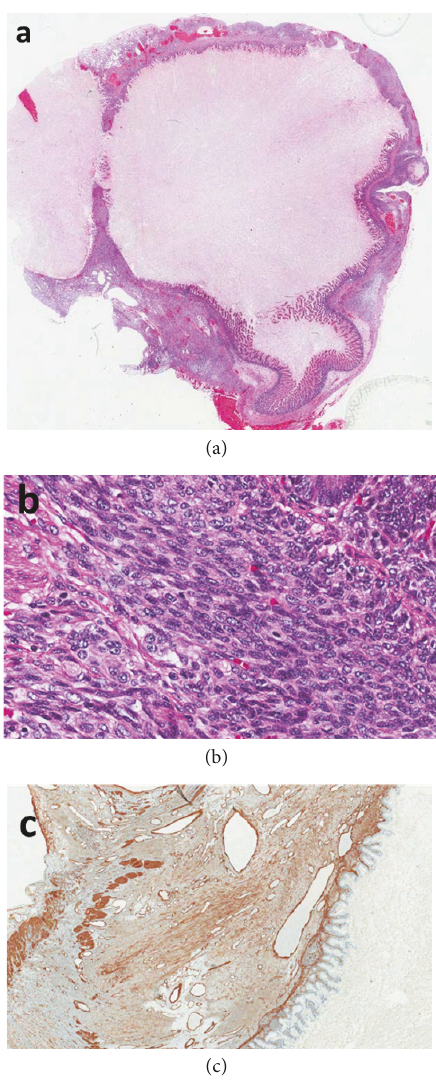
Figure 3: Histopathology revealed circumferential spindle cell pro- liferation involving mainly the submucosa and muscularis propria (a); the tumor consisted of spindle cells with tapering nuclei and indistinctive eosinophilic cytoplasm (b); immunohistochemistry showed focal positivity of tumor cells for SMA